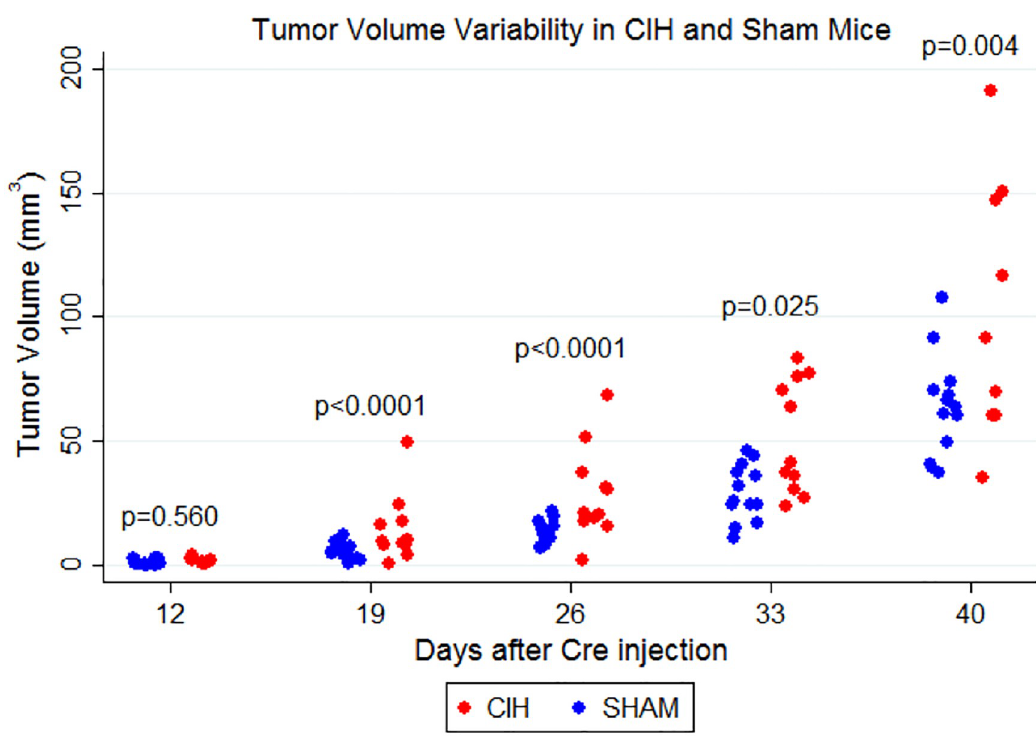
Fig 5. Variability in tumor volume as measured by micro CT scans. The measured tumor volume within the CIH and Sham groups in each time point is demonstrated. We found significantly greater variability in tumor volumes for the CIH group compared to Sham at day 19 (p < 0.0001), day 26 (p < 0.0001), day 33 (p = 0.025) and day 40 (p =